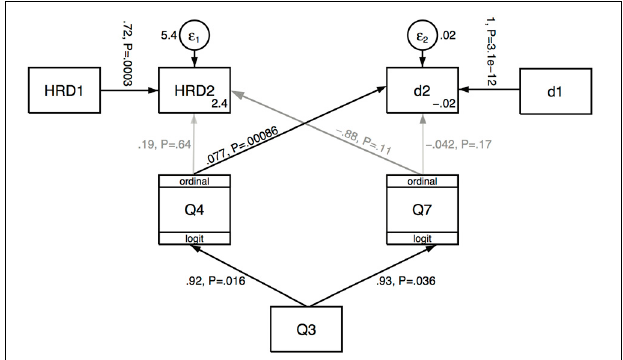
FIGURE 3 | Path analysis for HRD and distance measures in relation to questionnaire variables Q3, Q4, Q7. The values on the paths are the path coefficients followed by their significance levels. The epsilon terms represent the random error term. The diagram can be interpreted as a set of simultaneous linear prediction equations, e.g., HRD2 = 2 . 4 + 0.19 ∗ Q4 − 0.88 ∗ Q7 + 0.72 ∗ HRD1 + epsilon. The interpretation of the paths to the ordinal variables (Q4, Q7) is more complex (see main text). The circles are the random error terms and values by the epsilon circles are their variances. The lighter arrows indicate the non-significant paths.